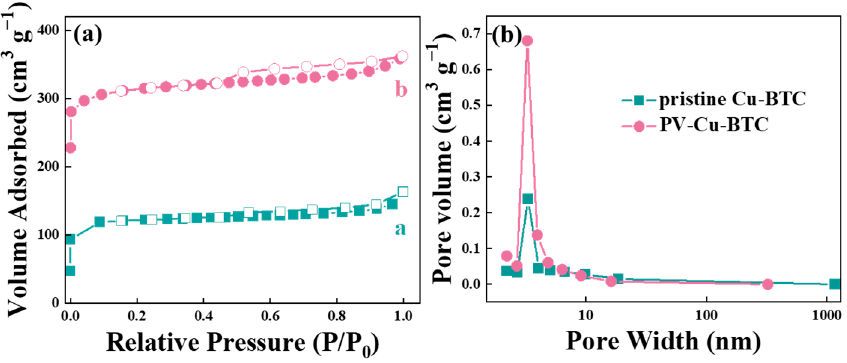
Figure 4. ( a ) N 2 adsorption-desorption isotherms and ( b ) pore size distribution curve of pristine Cu- BTC and PV-Cu-BTC. Table 2. Texture structure parameters of pristine Cu-BTC and